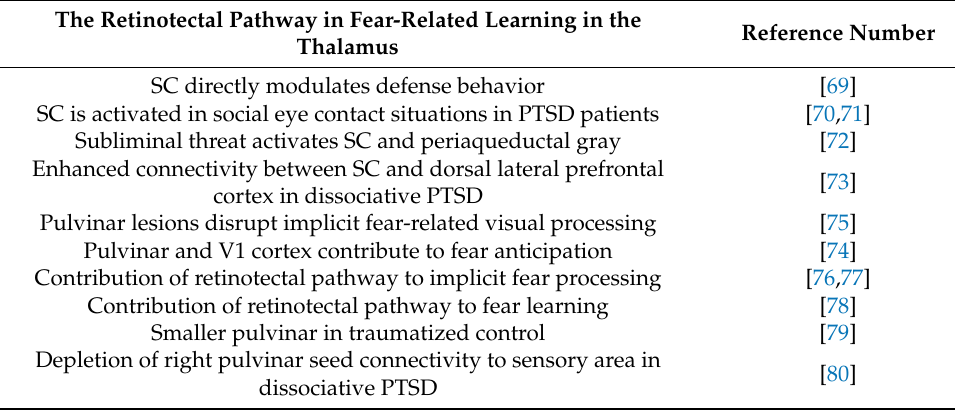
Table 3. The summary of literature study for the retinotectal